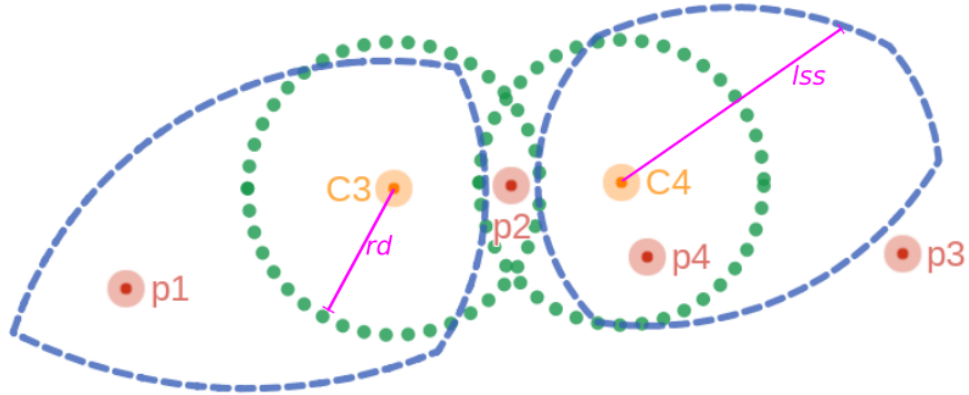
Figure 5. Representation of boundaries used to detect significant change for evidence